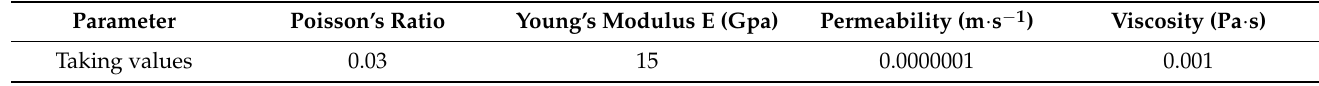
Table 1. Model parameter